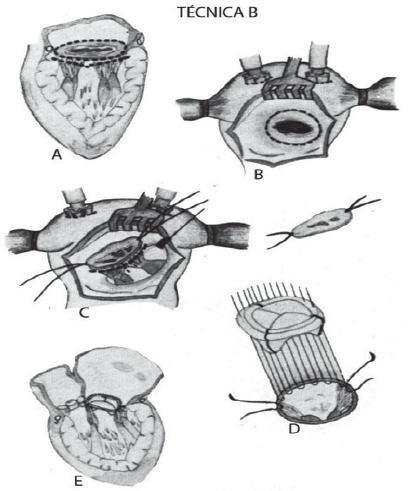
Fig. 2 - Prótese mitral com preservação dos elementos do sistema subvalvar: fixação dos músculos papilares e cordas tendíneas no anel posterior (Évora et al., Rev Bras Cir Cardiovasc.